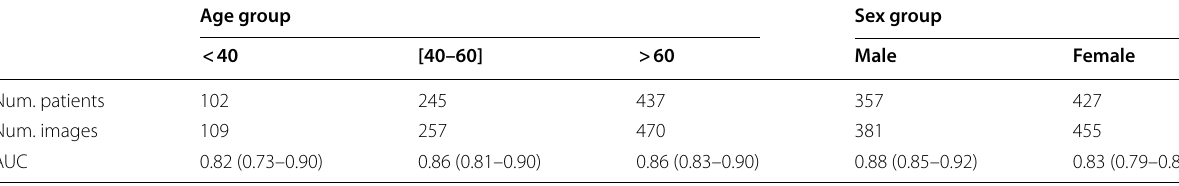
Values in parenthesis are 95% confidence intervals